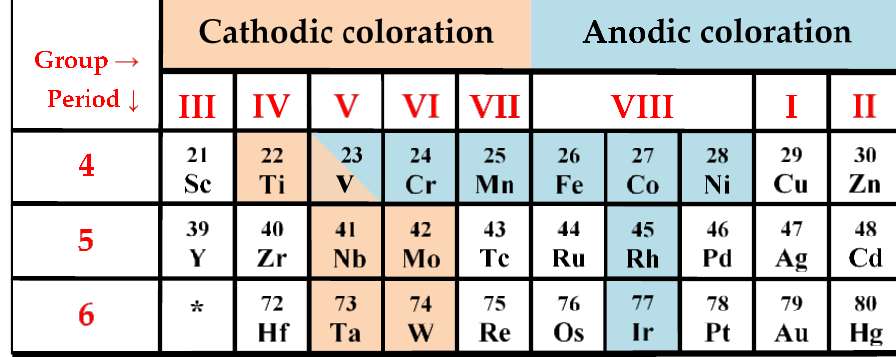
Figure 12. Electrochromic transition metal oxides. * — lantanoids.